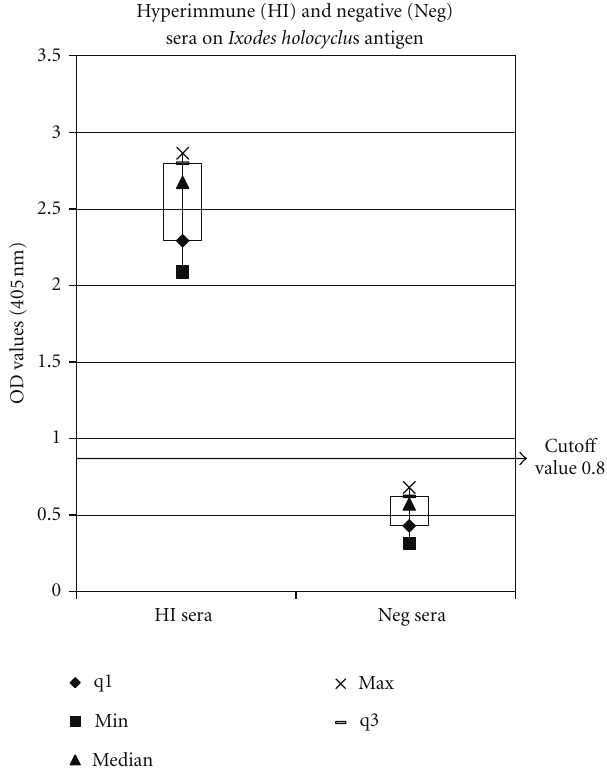
Figure 2: Reactivity of 10 HI and 10 negative dog serum samples tested in ELISA shown in a Box and Whisker diagram: q1 lower quartile, cuts o ff lowest 25% of data; q3 third quartile, cuts of highest 25% of data.